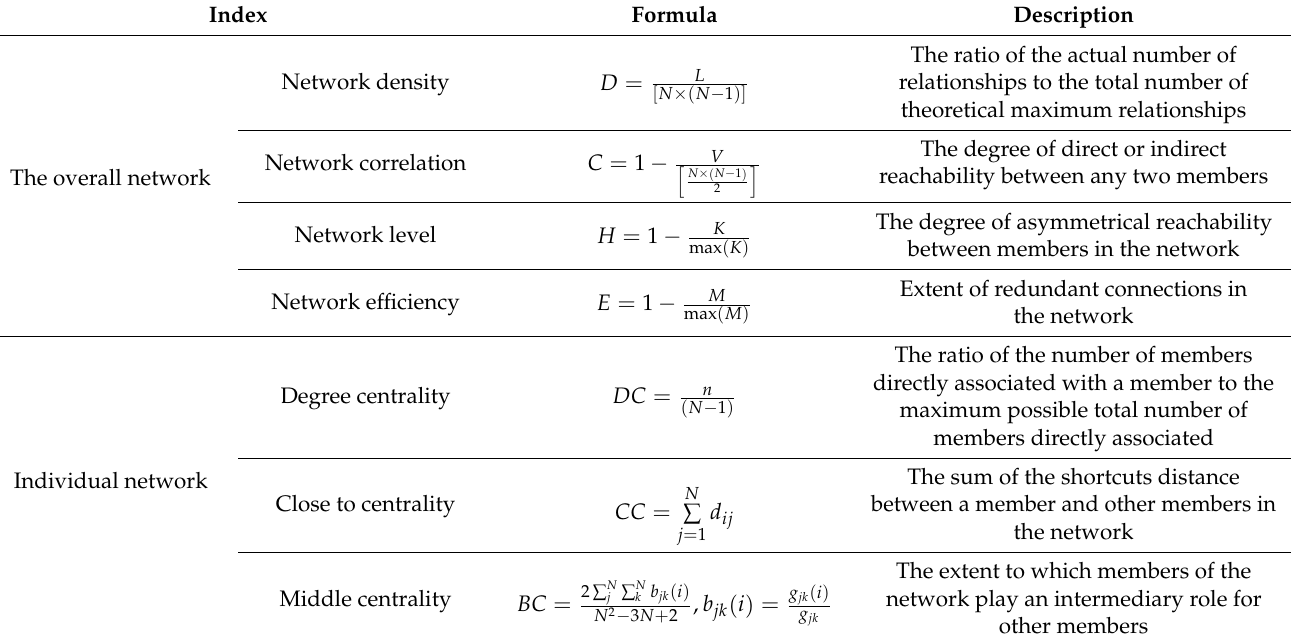
Table 3. The calculation and explanation of the main indicators of the analysis of the spatial correlation network characteristic of the ASTR allocation efficiency.